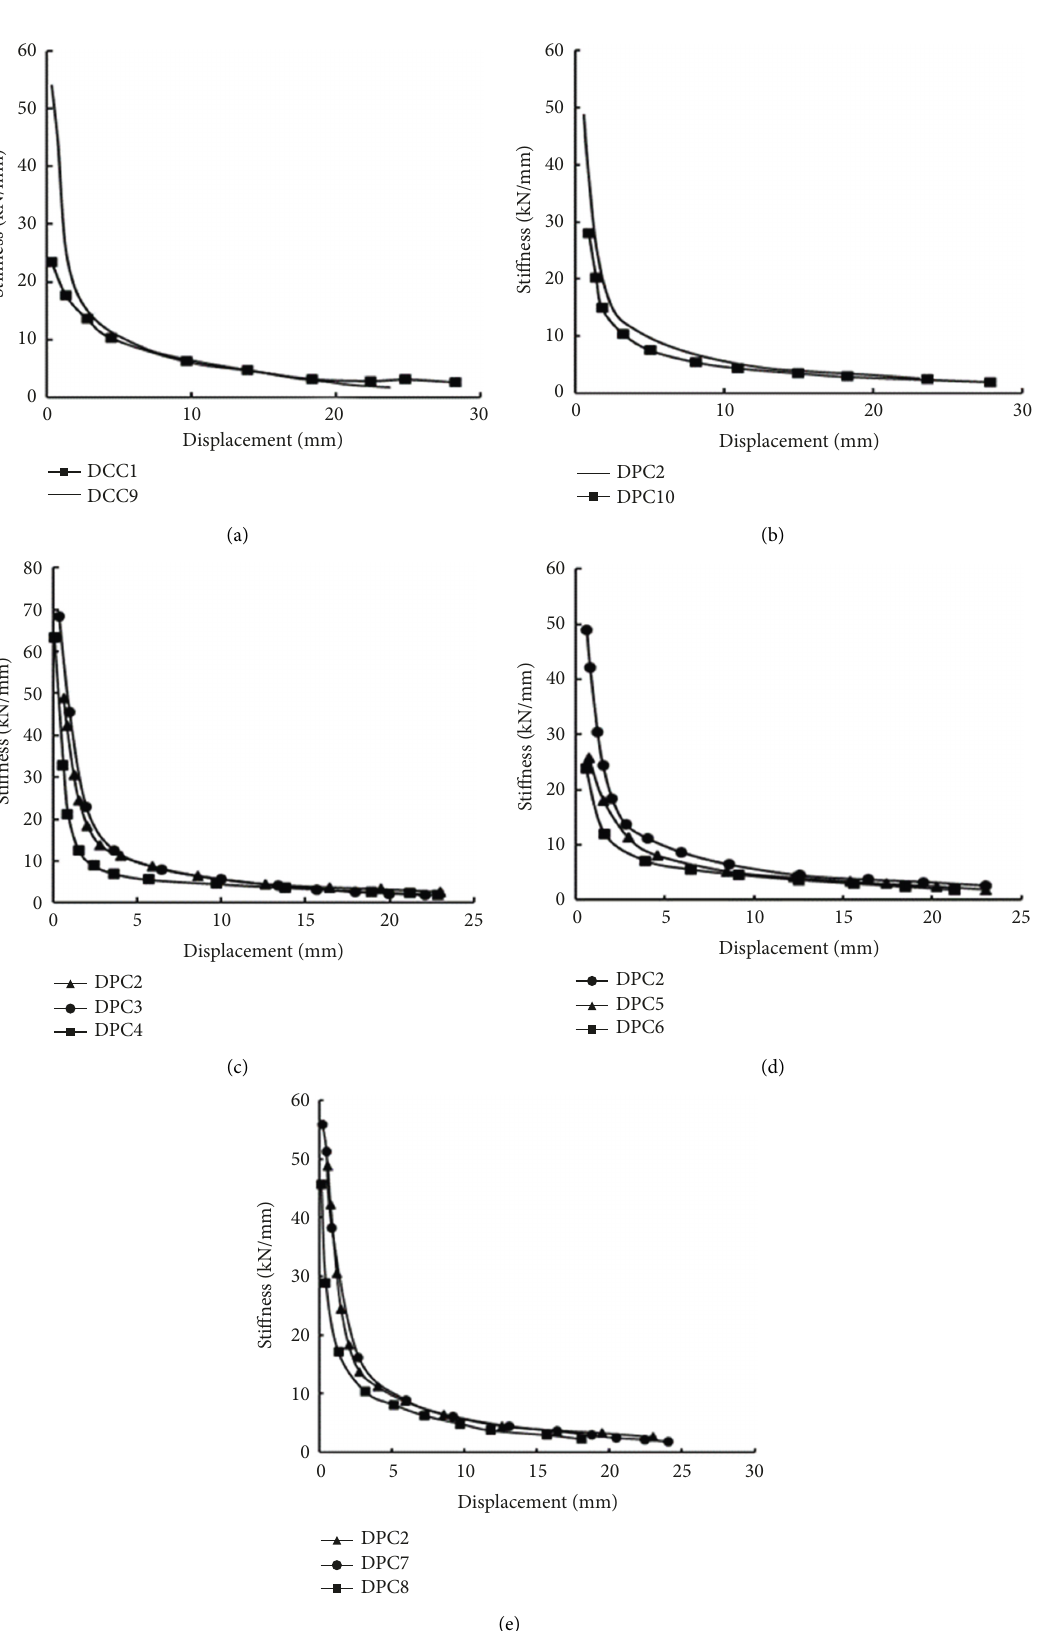
Figure 15: Stiffness degradation curves. (a) DCC1 and DCC9. (b) DCC2 and DCC10. (c) Equivalent area ratio as a variable. (d) Grouting strength as a variable. (e) Assembly area length as a